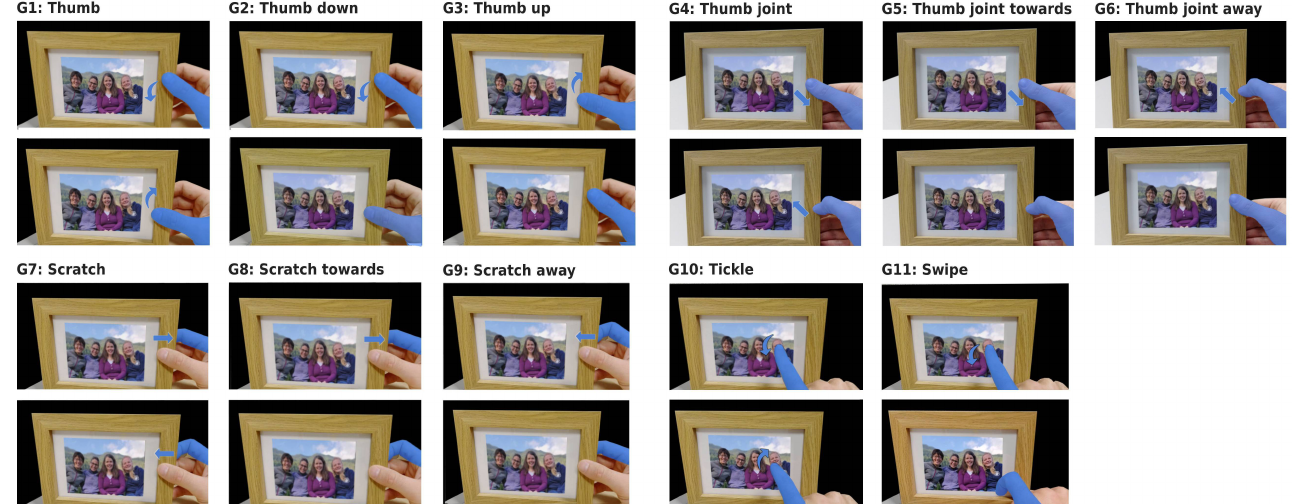
Figure 6. Gesture set for on-object interaction based on the existing literature and heuristic analysis. Gestures are divided in (i) bidirectional gestures—gestures which include movements in two directions (G1, G4, G7, G10); and (ii) unidirectional gestures—gestures which include movement in one direction only (G2 and G3, G5 and G6, G8 and G9, G11).